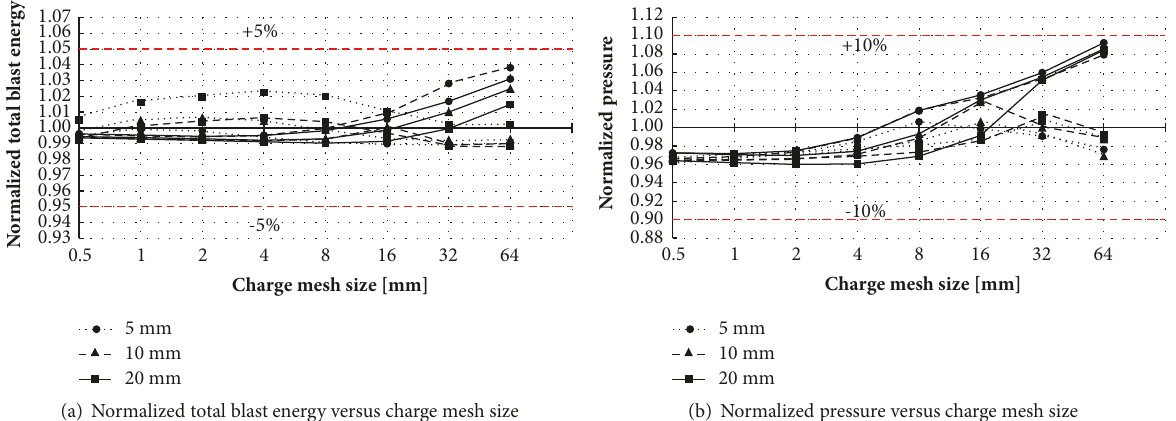
(a) Normalized total blast energy versus charge mesh size (b) Normalized pressure versus charge mesh size Figure 1: Influence of charge mesh size on blast energy and pressures (solid line: 115 kg TNT; dashed line: 230 kg TNT; dotted line: 680 kg TNT).